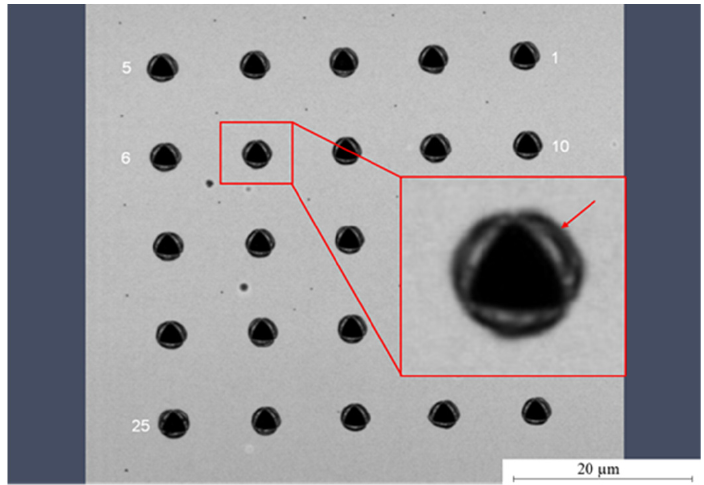
Figure 9. Light microscopic image of the nano-indents on Parylene C. The typical pile-ups (arrow) observed for soft materials is clearly visible.